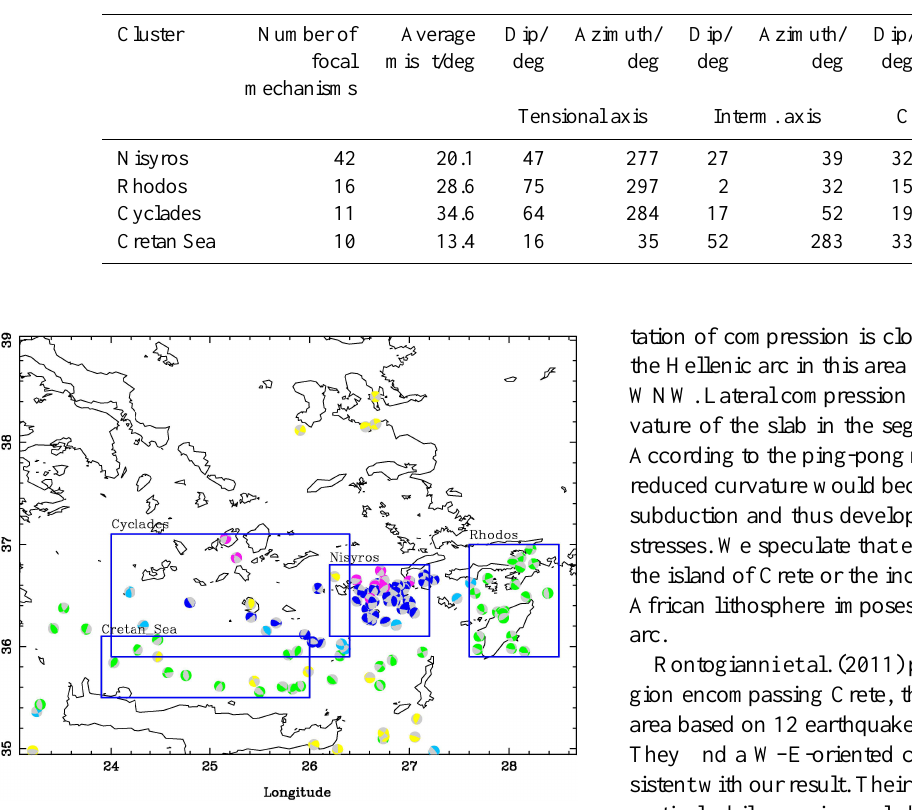
Table 3. Summary of stress inversion results for shallow earthquake clusters. Clusters are ordered according to the number of available focal mechanisms. Azimuth is measured in degrees from north over east.